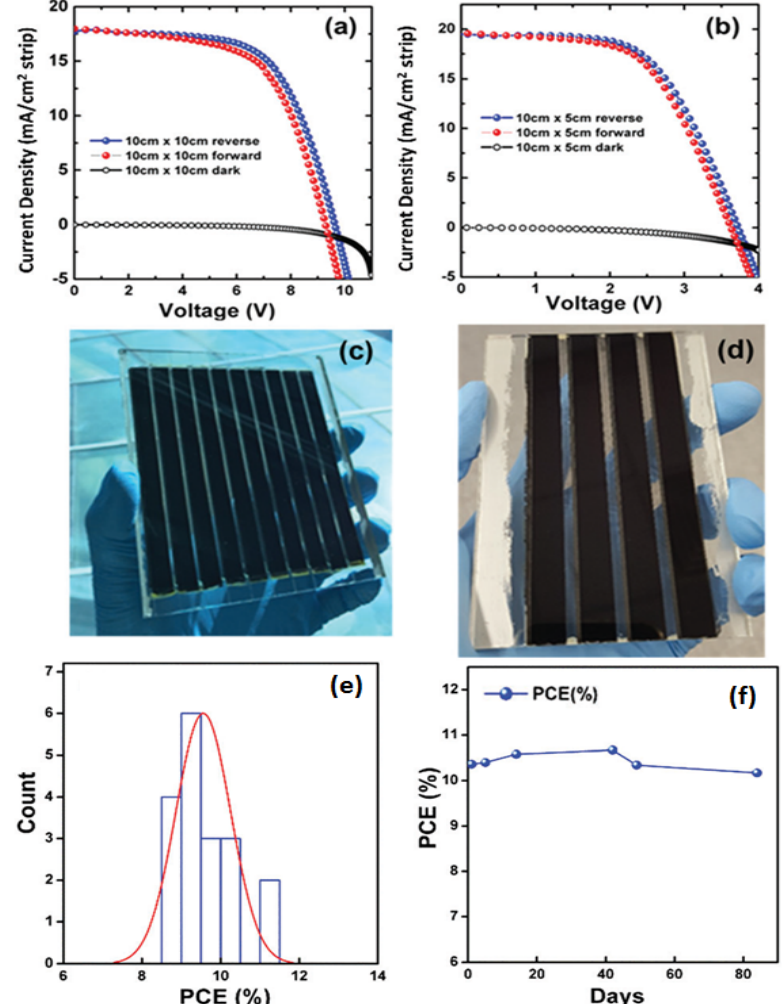
Figure 14. Current density vs. voltage curve under AM 1.5 G illumination: ( a ) 10 cm × 10 cm device (active area 70 cm 2 ), ( b ) 10 cm × 5 cm device (active area 31 cm 2 ), ( c ) of 10 cm × 10 cm device ( d ) 10 cm × 5 cm device. ( e ) PCE of 18 modules made in one batch and ( f ) PCE of module with time [92]. (Reproduced from Ref. [92], 10.1039/C6EE02693A, with